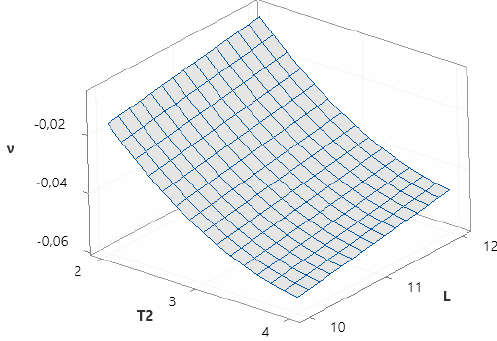
Figure 15. Surface plot of F max and T 1; L (for T 2 = 3 mm)